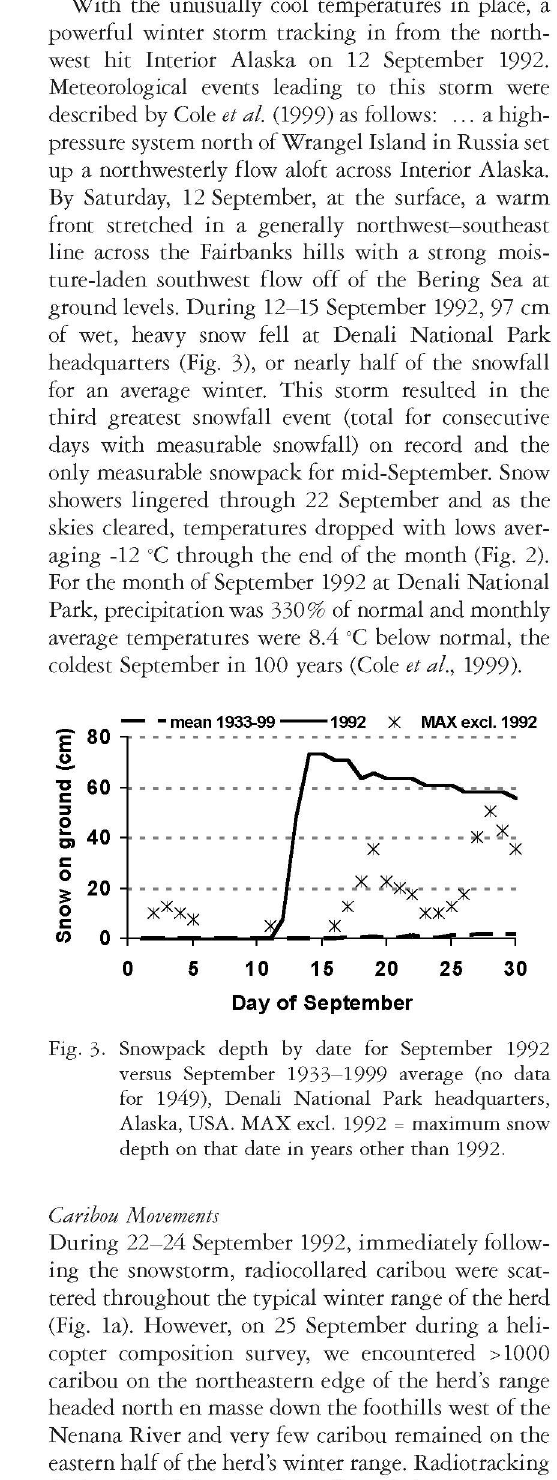
Fig. 3. Snowpack depth by date for September 1992 versus September 1933—1999 average (no data for 1949), Denali National Park headquarters, Alaska, USA. M AX excl. 1992 = maximum snow depth on that date in years other than